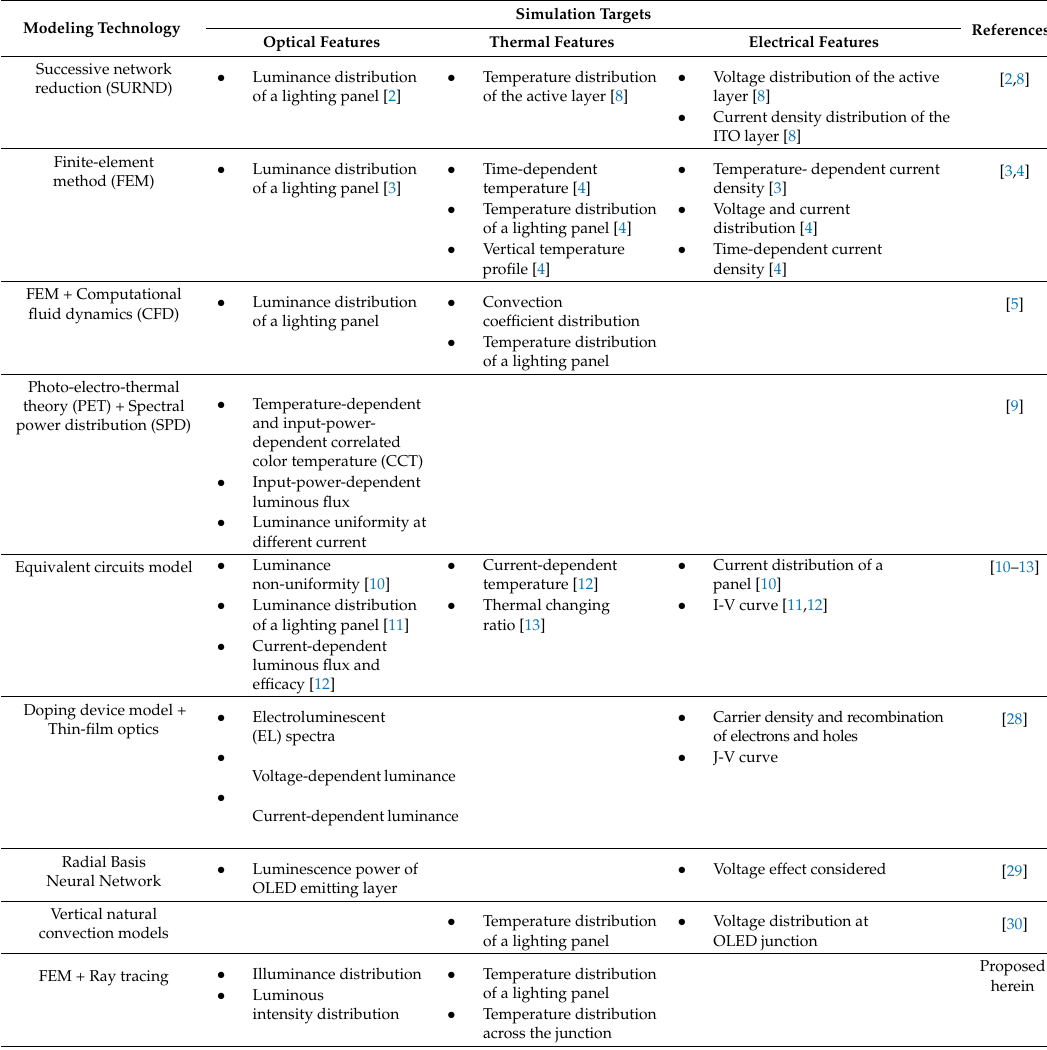
Table 3. Integrated-modeling technologies for OLED